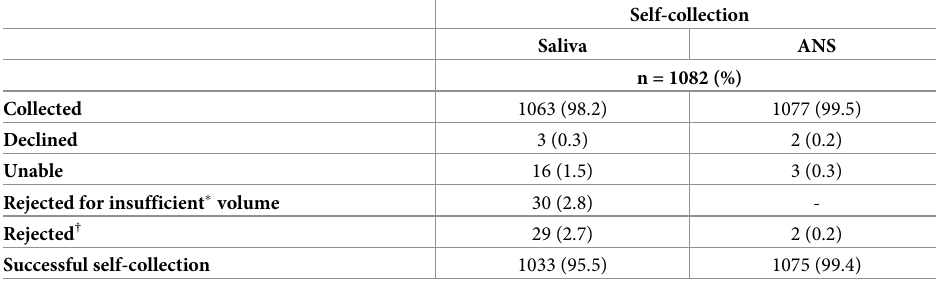
Self-collection Saliva ANS n = 1082 (%)